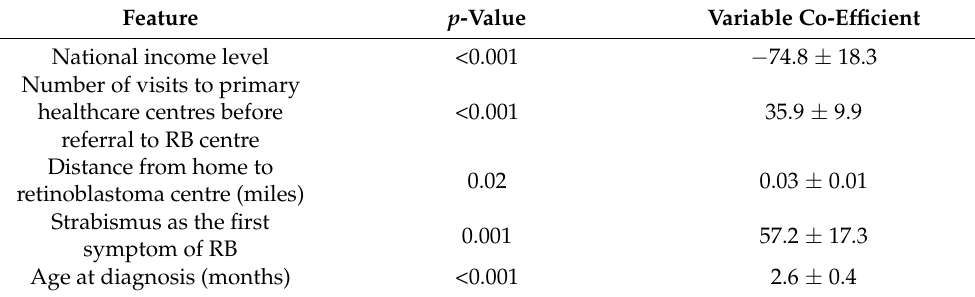
Table 3. Multivariate linear regression analysis of factors affecting lag time between first symptom and treatment of retinoblastoma in 692 patients from 10